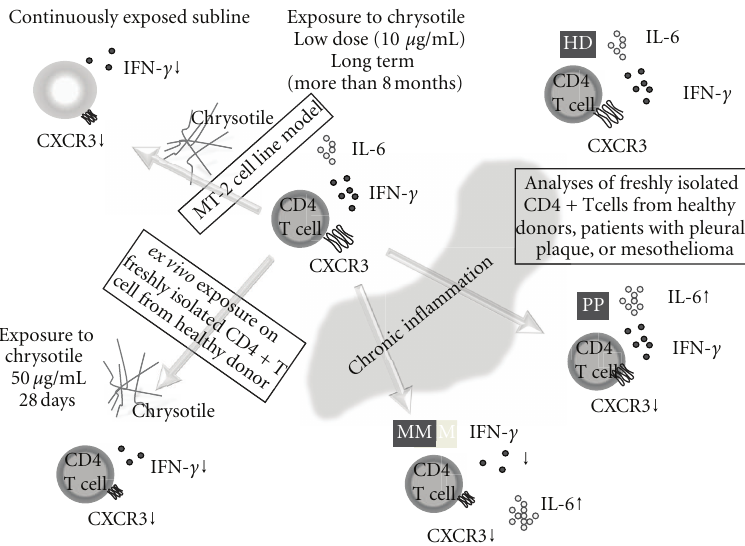
Figure 2: Schematic representation of asbestos-induced reduction of expression of a chemokine receptor, CXCR3, and expression and pro- duction of IFN- γ with increasing IL-6 using the MT-2 cell line model exposed continuously to a low dose of chrysotile (upper left), an ex vivo exposure model using freshly isolated CD4+ T cells from healthy donors (HD) (lower left) as well as analyses of freshly isolated CD4+ T cells from healthy donors and patients with pleural plaque (PP) and malignant mesothelioma (MM) (right).